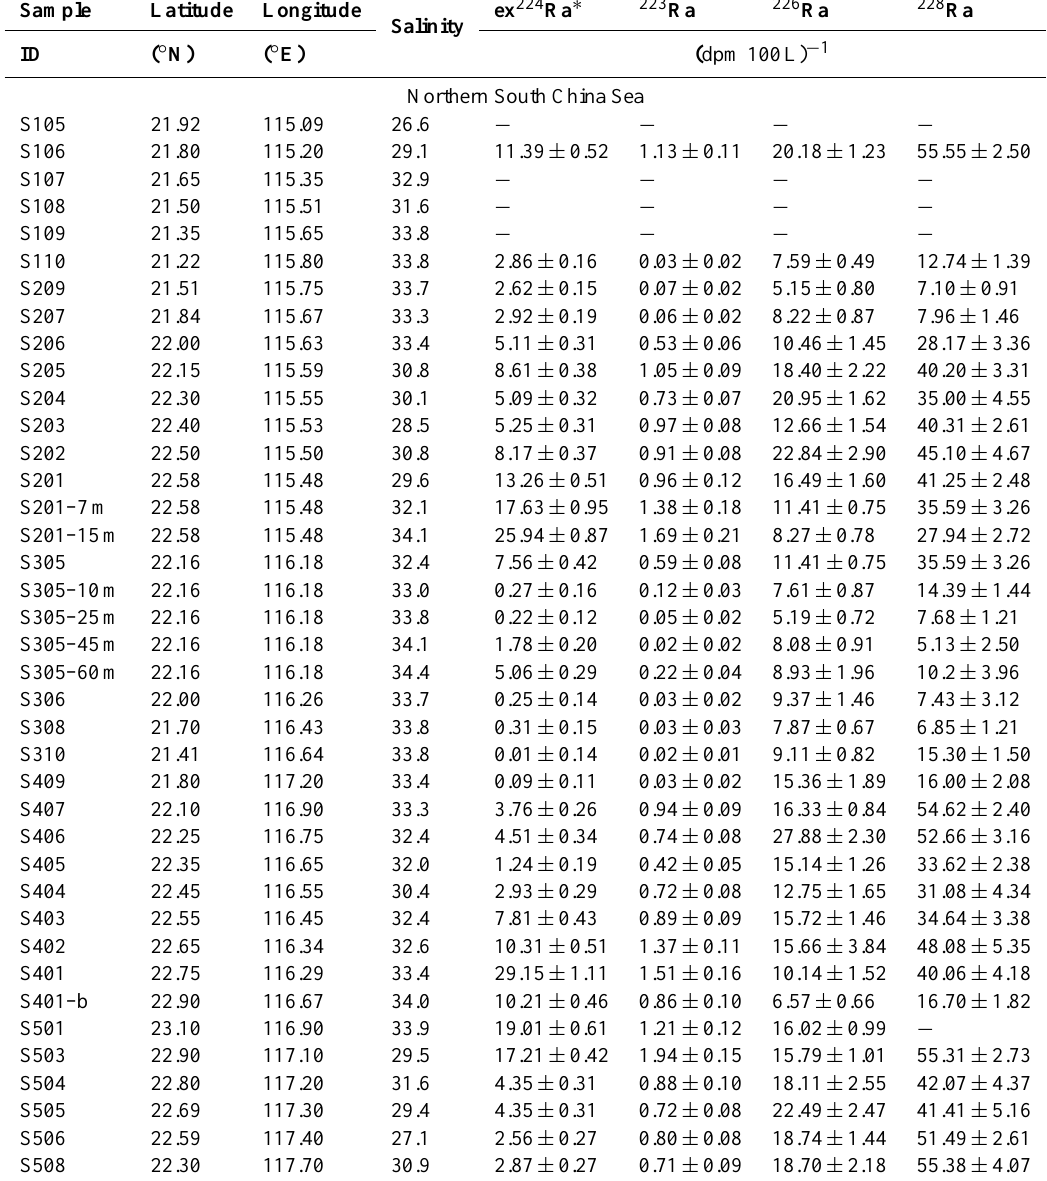
Table 1. Activities of Ra isotopes at the sampling sites # on the northern South China Sea shelf and in the Pearl River estuary. Sample Latitude Longitude